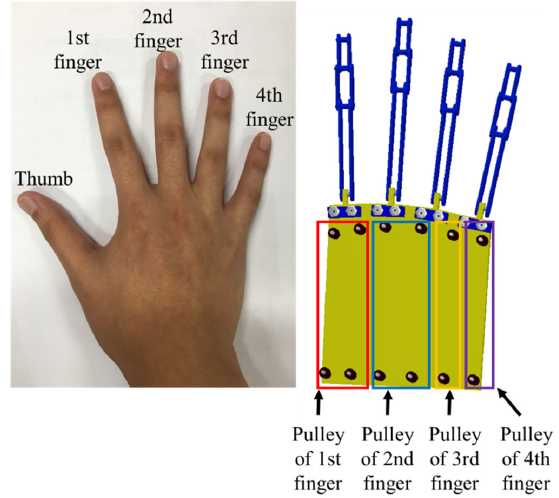
Figure 11. Prosthetic hand with SMA actuator [90].